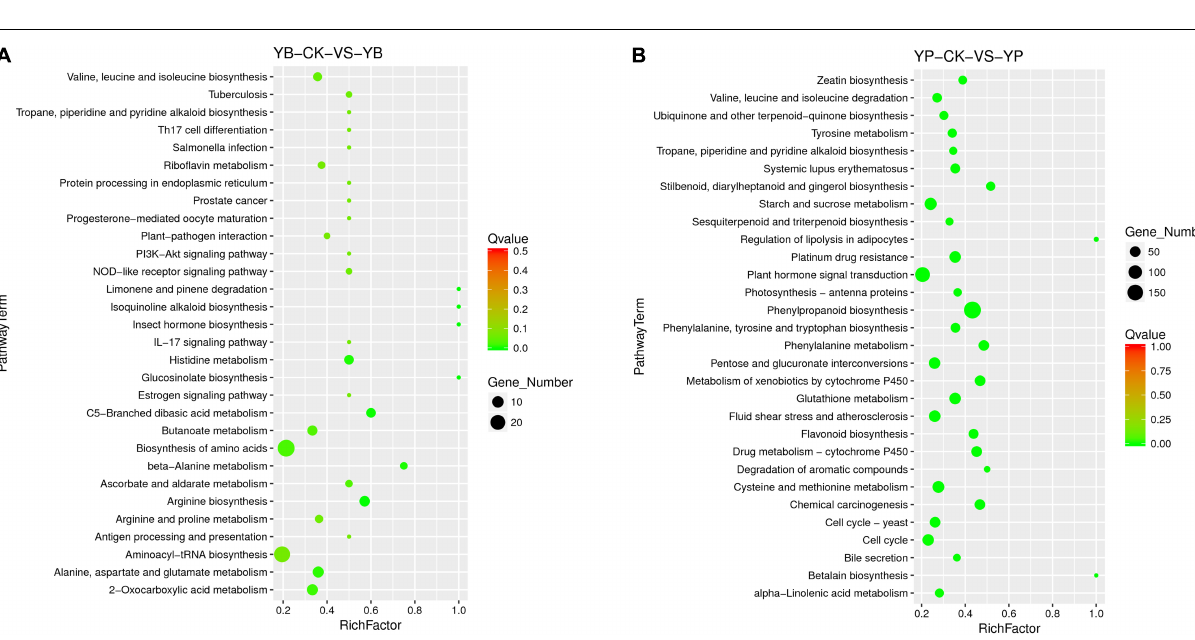
FIGURE 5 | KEGG enrichment analysis of differentially expressed genes (DEGs) in the interaction transcriptome. KEGG enrichment of different genes was performed using KOBAS software. The degree of KEGG enrichment is measured by the Rich factor, the Q -value, and the number of genes enriched in this pathway. Rich factor refers to the ratio of the number of DEGs in the pathway to the total number of all annotated genes in the pathway. The larger the Rich factor, the greater the degree of enrichment. Q -value is the p -value after correction for multiple hypothesis testing. The value range of Q -value is [0,1]; the closer to zero, the more significant the enrichment. (A) KEGG enrichment of DEGs in strain YC0136. YC0136 cells in the YC0136-tobacco co-cultured group were labeled YB. YC0136 cells in the control group were labeled YB-CK (B) KEGG enrichment of DEGs in tobacco. Tobacco roots from the co-cultured group were labeled YP, and tobacco roots from the control group were labeled